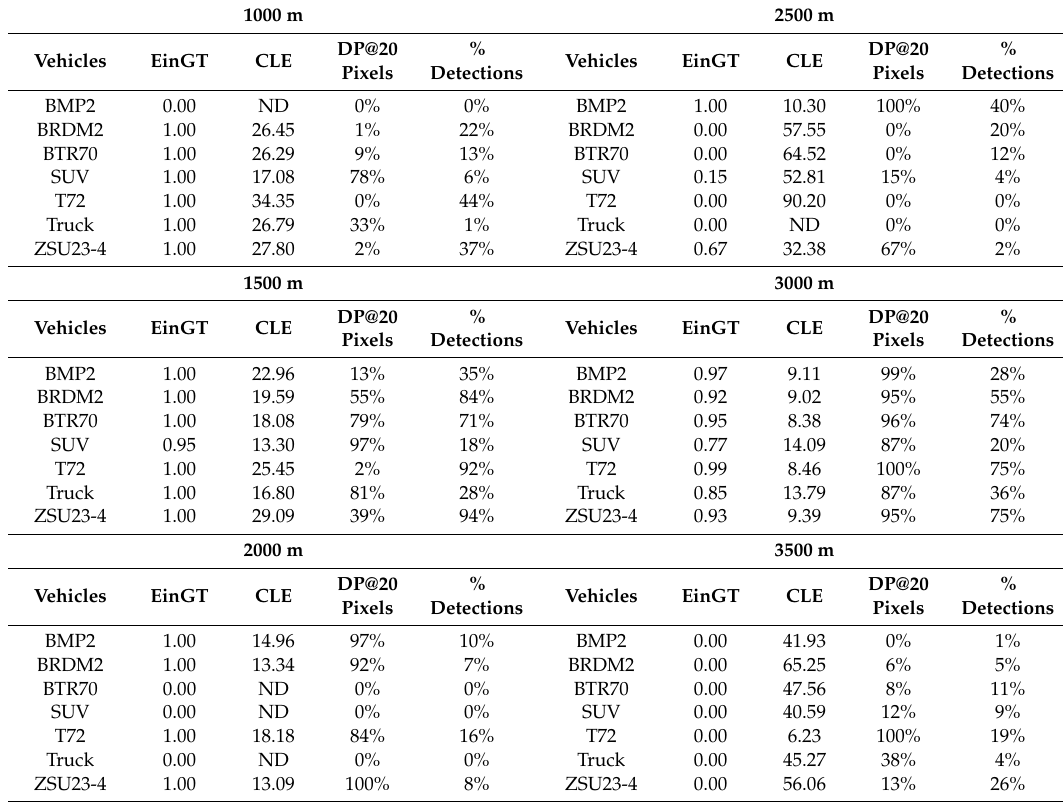
Table A5. Tracking metrics for PCE 50 (MWIR daytime) case. 1500 m and 3000 m were used for